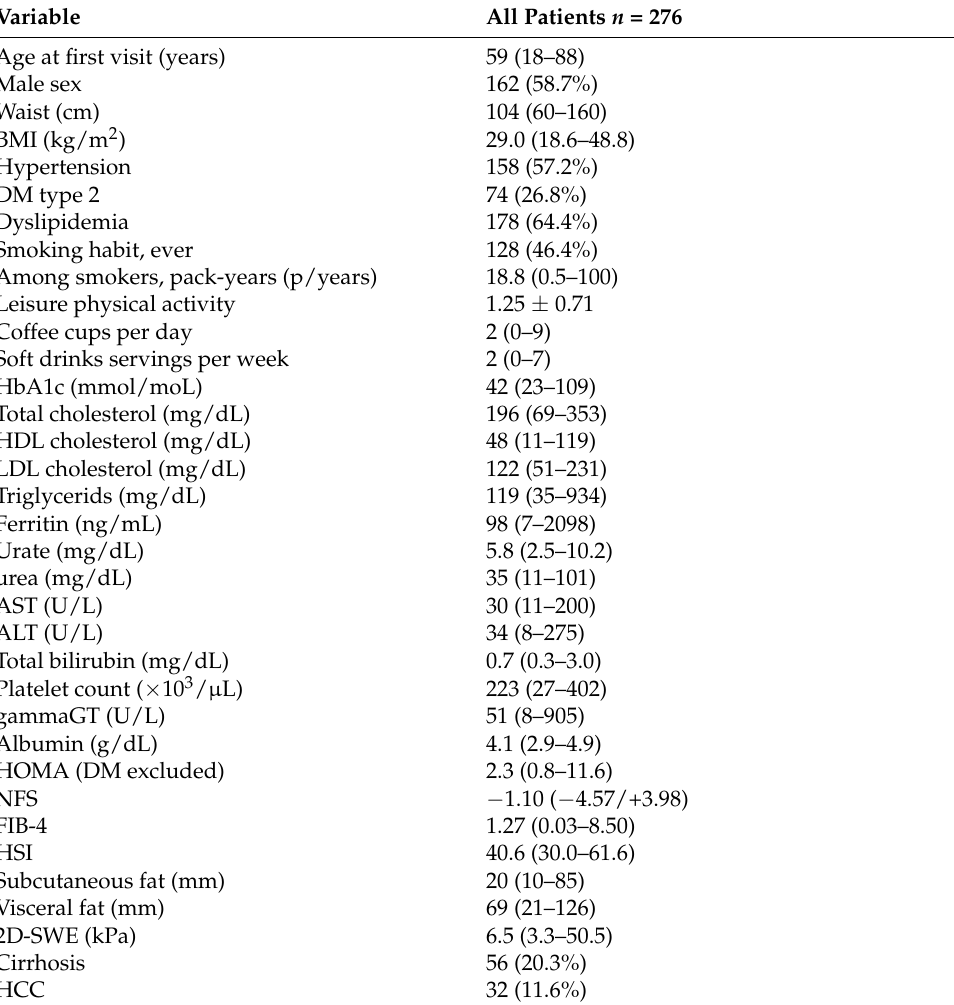
Table 1. Clinical, demographic, laboratory and ultrasound characteristics of all patients with